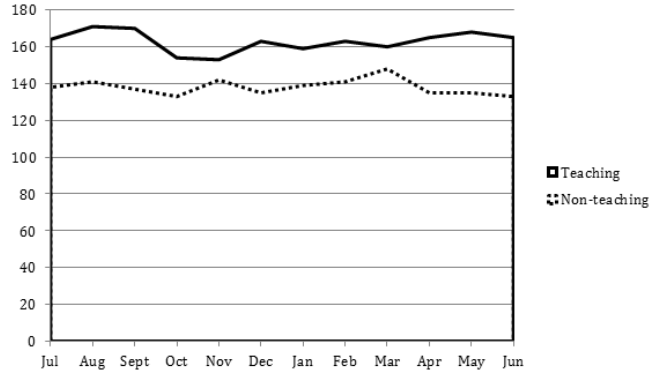
Figure. Comparing emergency department length of stay medians (in minutes) for teaching and non-teaching hospitals throughout the